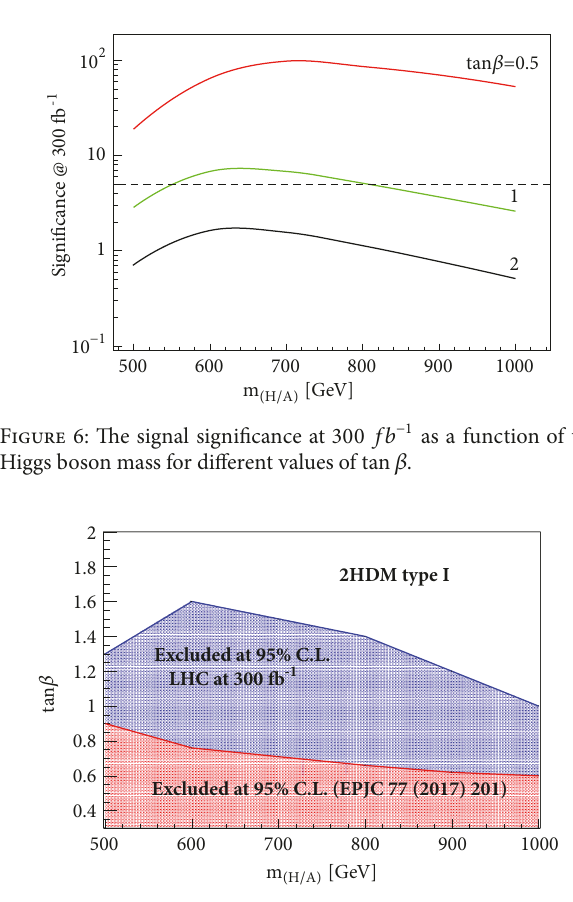
Figure 7: The 95 % C.L. exclusion region at 300 𝑓𝑏 −1 .